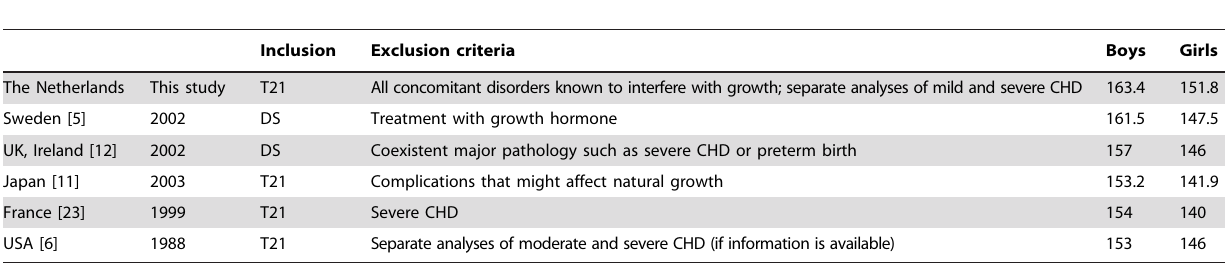
Abbreviations: T21 – Trisomy 21, DS – Down syndrome (including DS caused by Trisomy 21, mozaı¨cisme or translocation), CHD – congenital heart defect. doi:10.1371/journal.pone.0031079.t006 PLoS ONE |